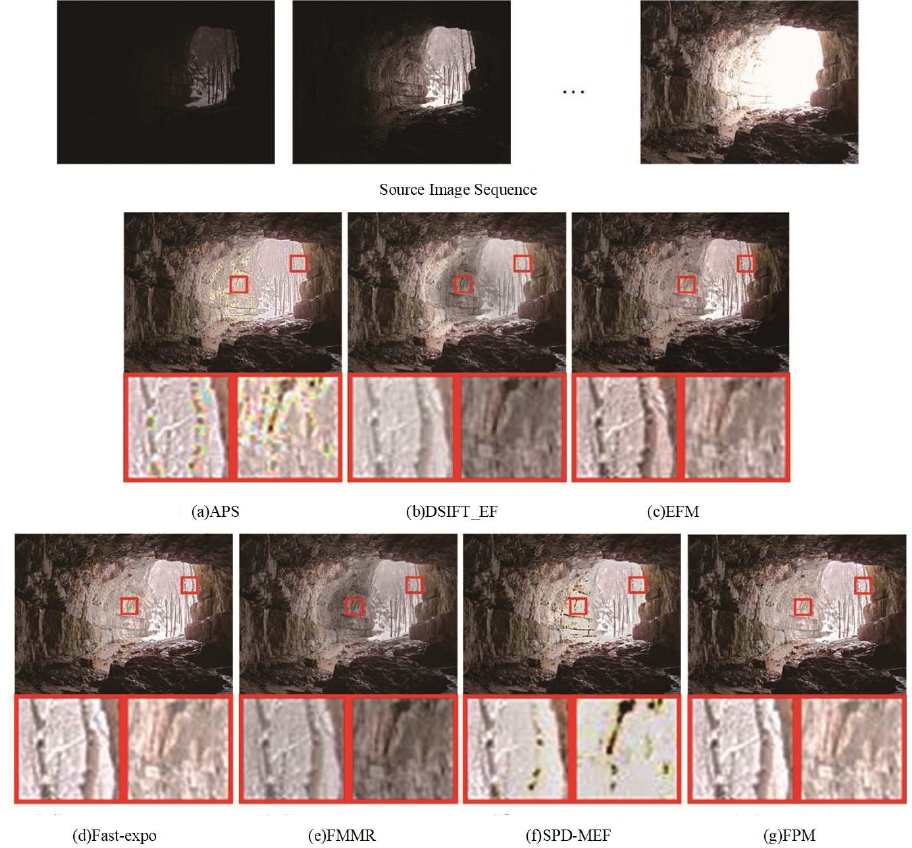
Figure 3. Comparison of the “Cave” fusion images obtained by the seven fusion methods. ( a )